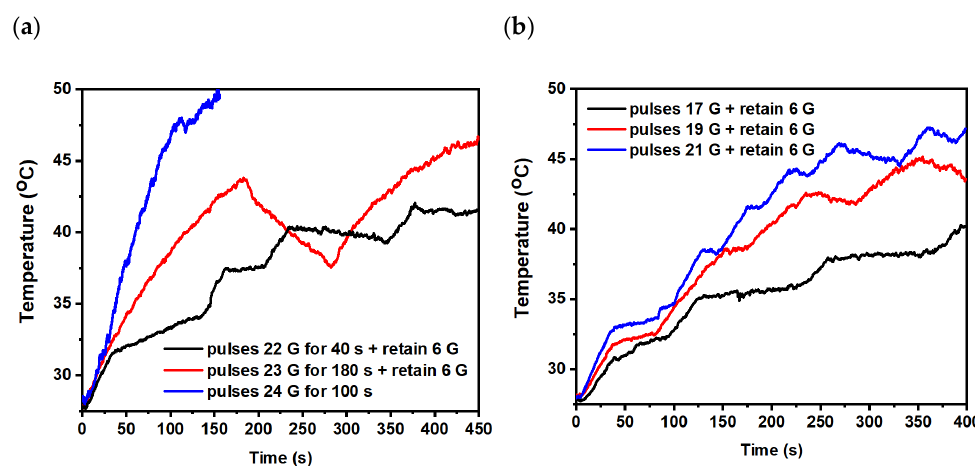
Figure 15. Temperature change in time for 20 mg mL − 1 where the AMF was applied with different amplitude by pulses ( a ) 22–24 G with retain 6 G and ( b ) 17–21 G with retain 6 G, where f = 540 kHz.